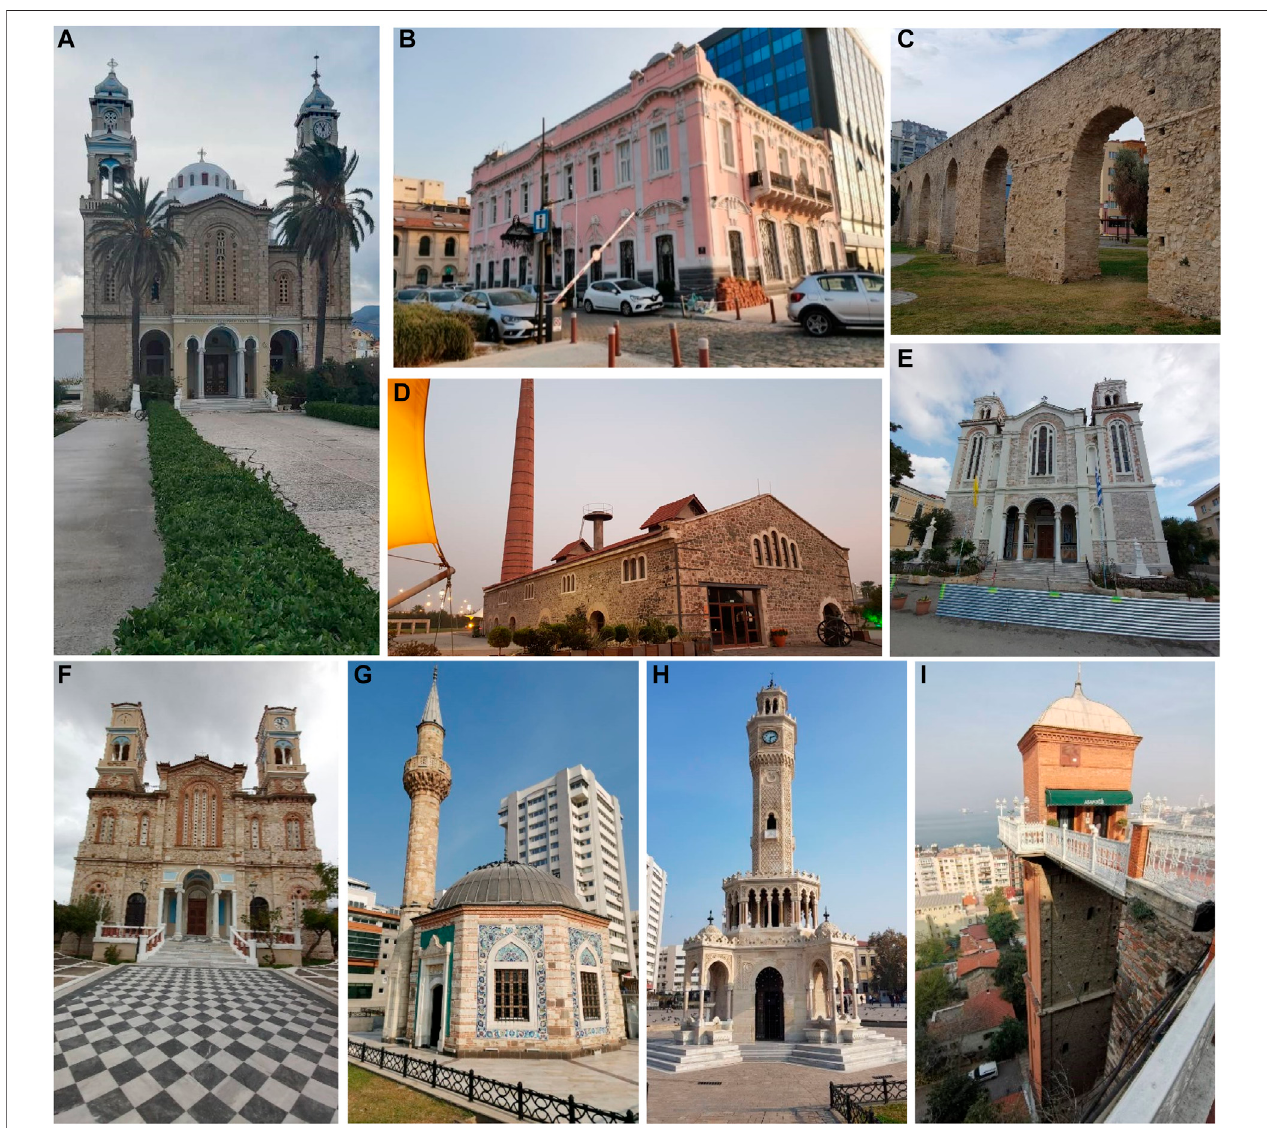
FIGURE 14 | Historic masonry buildings in the affected areas: (A) Agios Nikolaos in Karlovasi, Samos (B) Izmir Culture and Tourism Building, Izmir (C) Aqueducts, Izmir (D) Gasworks, Izmir, Turkey (E) Saint Spyridon Church, Samos (F) Church of Presentation of Mary, Samos (G) Konak (Yal ı ) Mosque, Izmir (H) Izmir clock tower, Izmir (I) Asansör,